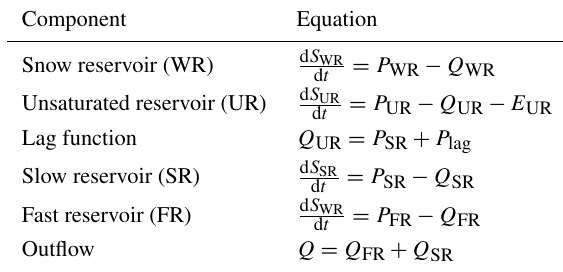
Table A2. Water-budget equations (see the model schematic in Fig.